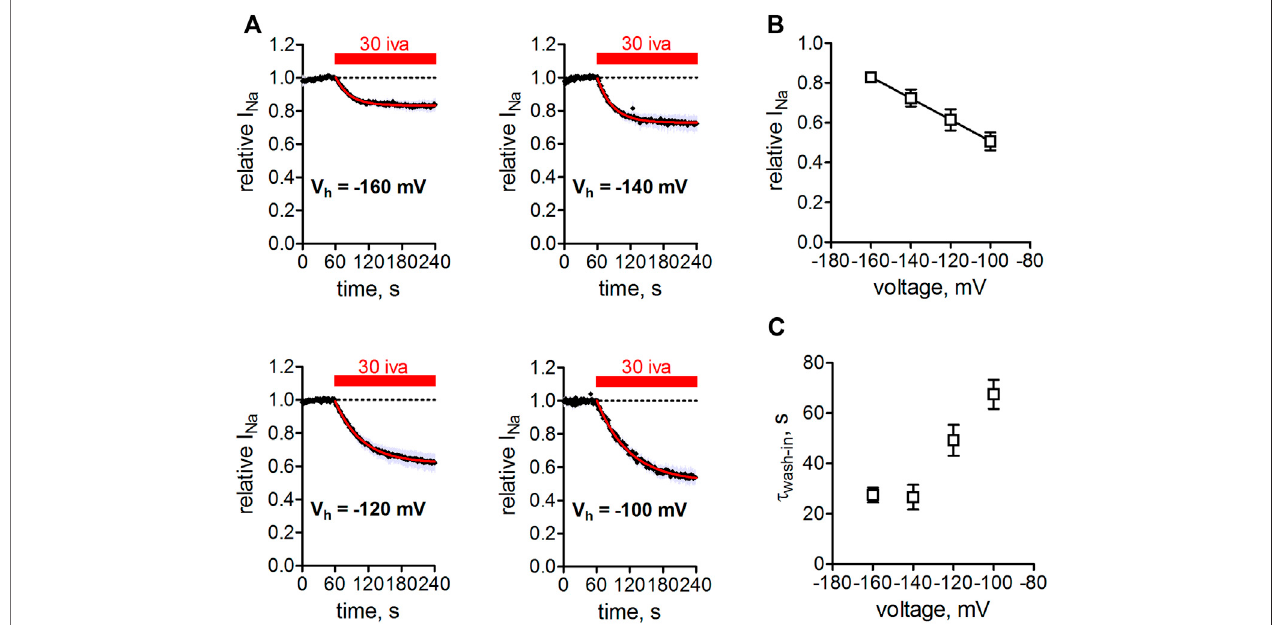
FIGURE 4 | Voltage-dependence of Na v 1.5 inhibition by ivabradine. (A) tsA-201 cells expressing human Na v 1.5 channels were held at different holding potentials (V h = − 160to − 100 mV)anddepolarizedto-10 mVfor25 mseverysecond.After60s,30 µMivabradinewasappliedfor3 min(redbar).Currentinhibitionwas fi ttedwith a mono-exponential function to derive steady-state inhibition levels. Measurements at V h = − 100 mV were corrected for Na v 1.5 current rundown caused by the mentioned time-dependent shift of inactivation in whole-cell experiments. (B) Summary of Na v 1.5 current amplitude in the presence of 30 µM normalized to